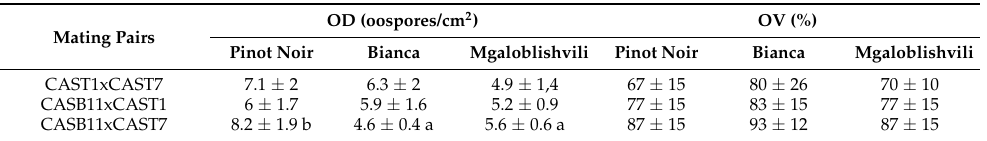
Table 5. Density (OD) and viability (OV) of P. viticola oospores differentiated by the three different mating pairs (CASB11xCAST1, CASB11xCAST7, and CAST1xCAST7) on the susceptible (Pinot noir) and resistant (Bianca and Mgaloblishvili) grapevine varieties. Different letters indicate the existence of significant differences among cultivars ( p < 0.05). OD (oospores/cm 2 ) OV (%) Mating Pairs Pinot